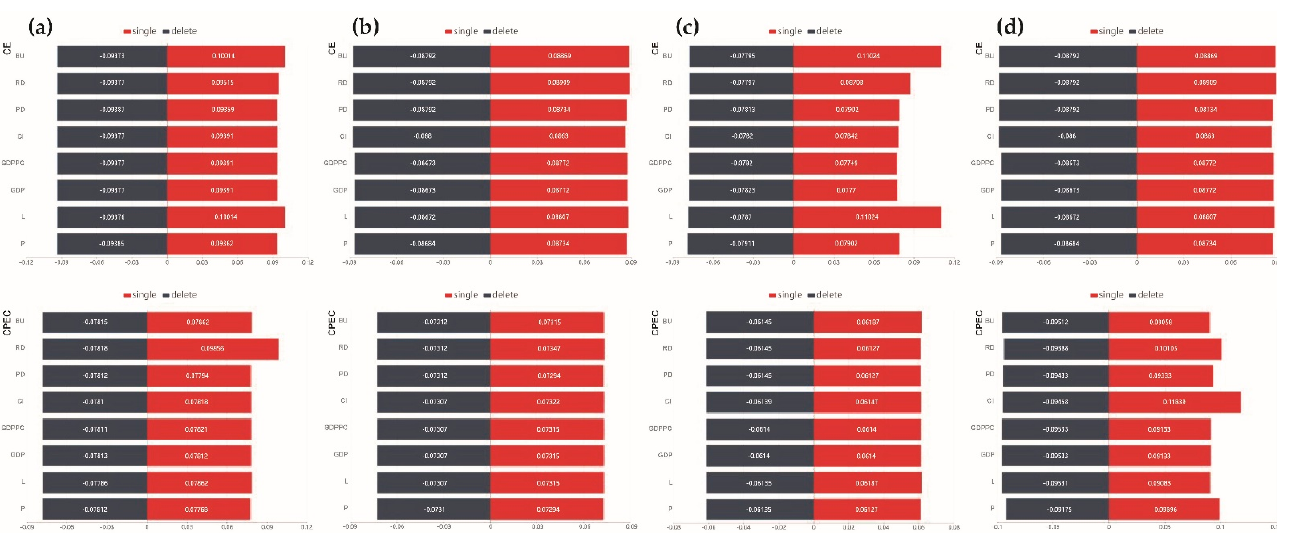
Figure 5. CEPC and influence factors regression results using XGBoost. ( a ) Beijing; ( b ) Tianjin; ( c ) Shanghai; ( d ) Chongqing.4.3. The importance of the influencing factors in single factor.